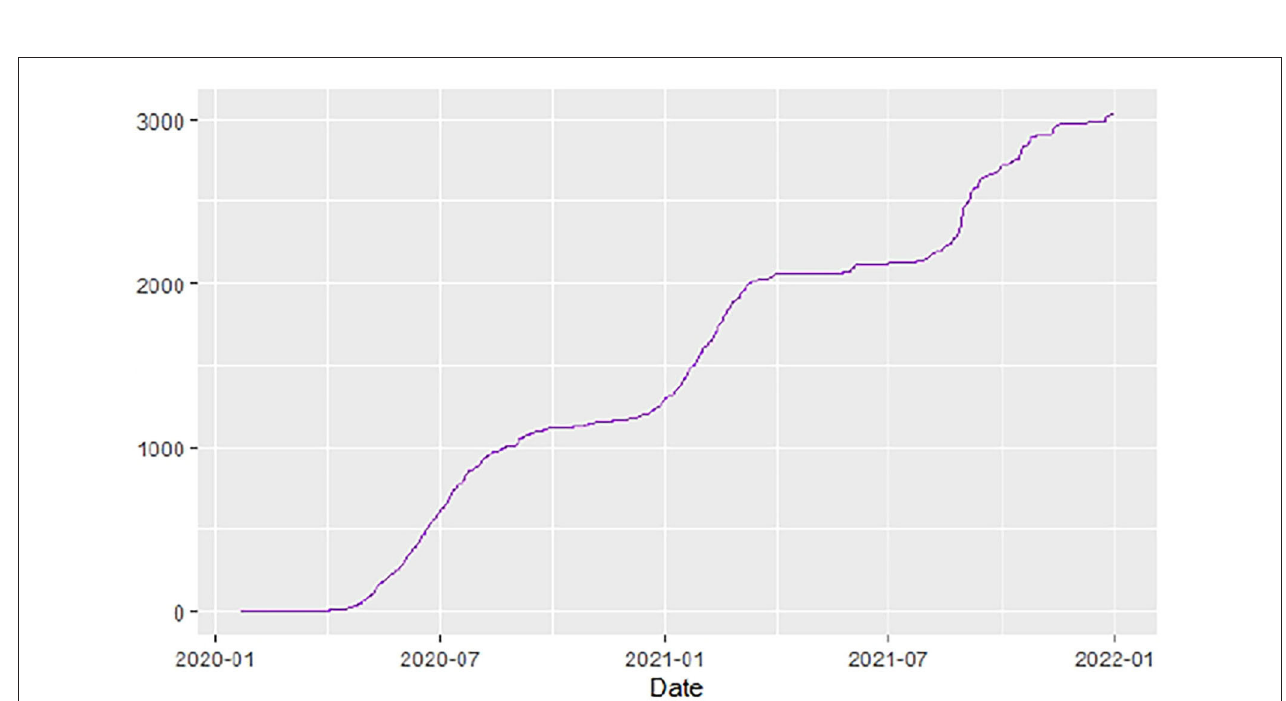
FIGURE 16 | Nigeria